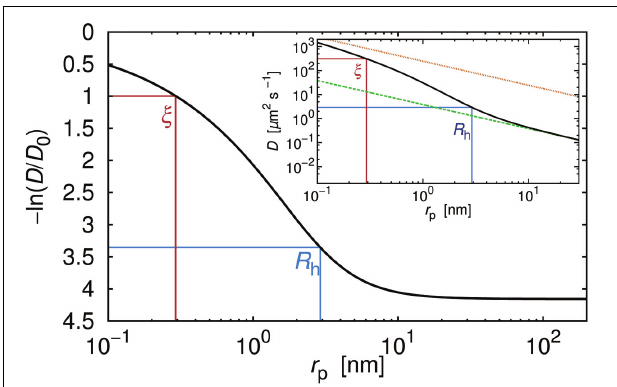
FIGURE 1 | Relative diffusion coefficient (diffusion coefficient divided by its value in pure water) as a function of the hydrodynamic radius r p of the hypothetical probe diffusing in the polyethylene glycol solution. Number averaged molecular weight of the polymer M n = 10944g/cm 3 . Concentration of the polymer was 20% by weight. Two characteristic length scales, ξ and R h determined the viscosity experienced by the probe. For probes whose r p was far smaller than ξ the probe diffused like in the solvent. For probes whose r p was longer than R h , the experienced viscosity reached the same values as the macroscopic viscosity of the solution. In the inset we showed absolute values of the diffusion coefficient for the same probes in the same polymer solution. The upper dotted line corresponded to the diffusion coefficient calculated according to the SSE equation (Equation 4) with η equal to the viscosity of the solvent η 0 . Bottom dashed line corresponded to the diffusion coefficient calculated according to the SSE equation (Equation 4) with η = η m (where η m denoted the macroscopic viscosity). For probes whose hydrodynamic radius was few times larger than R h , assumption that in Equation (4) η = η m seemed reasonable. For probes whose r p (cid:2) R h , assumption that η = η m failed in the same manner as the assumption that η = η 0